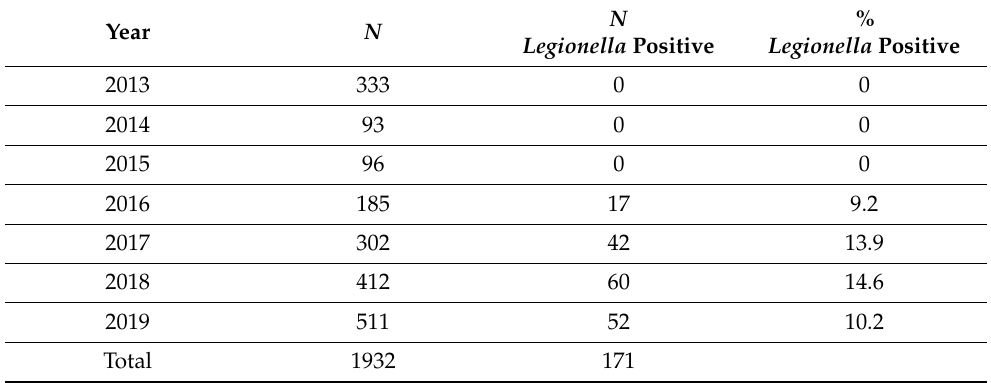
Table 1. Number of total samples analyzed, number and share of L. pneumophila -positive